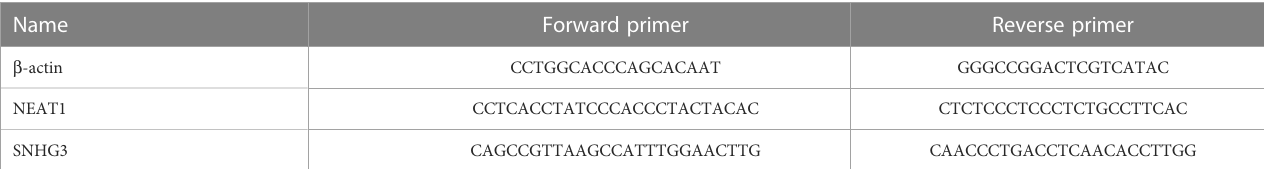
TABLE 1 Forward and reverse primers